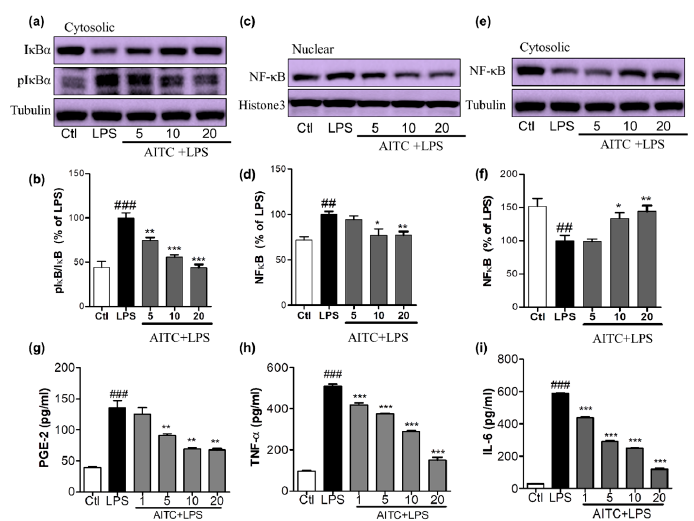
Figure 4. Effects of AITC on LPS-induced nuclear factor (NF)- κ B activation and proinflammatory cytokine production in BV2 cells. BV2 cells were treated with AITC 30 min prior to LPS treatment and